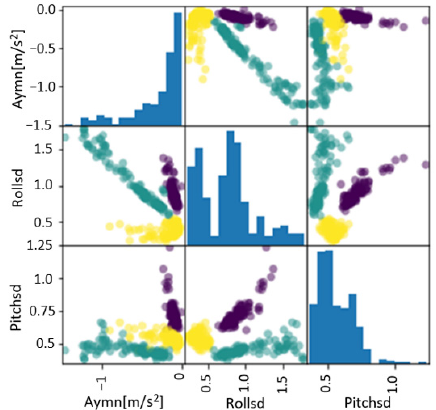
Figure 9. Relationship of the characteristics obtained after the dimensional reduction.